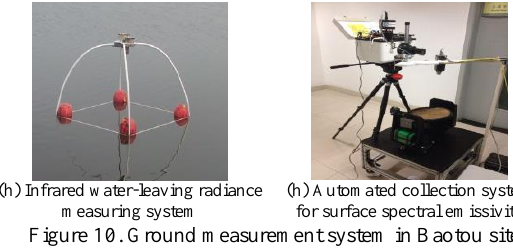
Figure 10. Ground measurement system in Baotou site